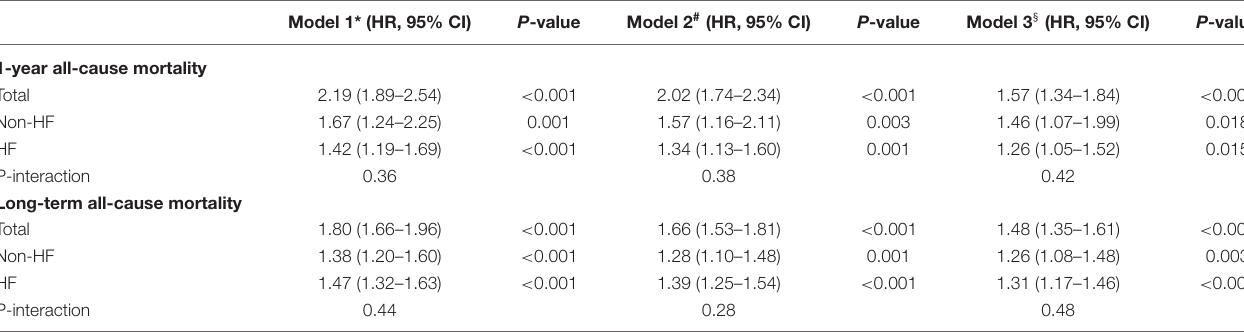
TABLE 2 | Cox proportional hazard ratios for 1-year and long-term all-cause mortality in different models.